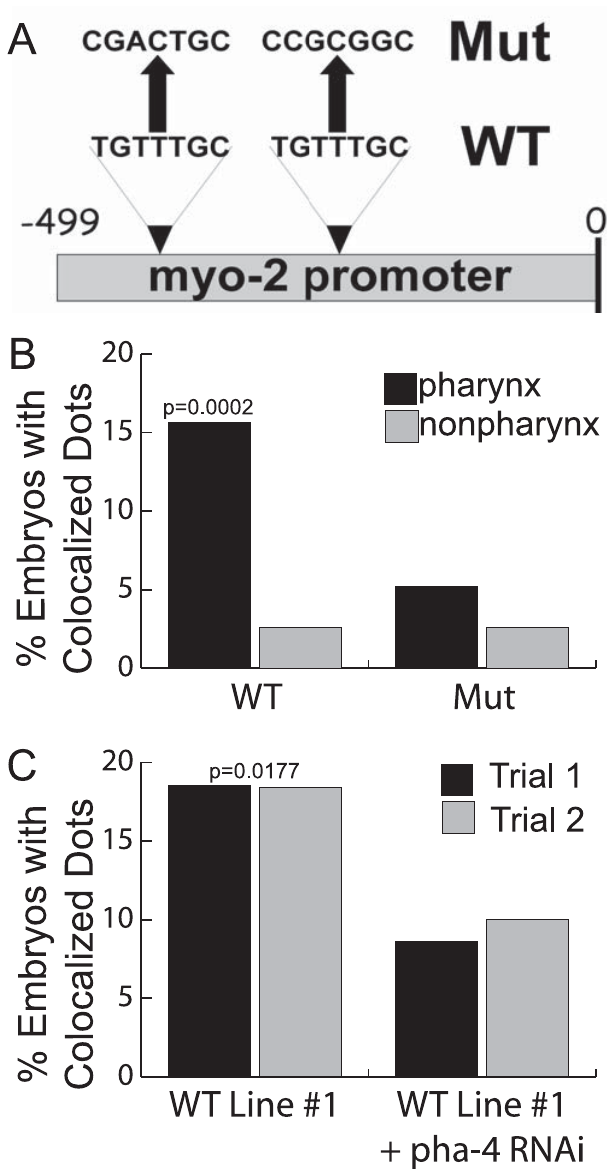
Figure 5. Association of YFP::HTZ-1 Depends on pha-4 Activity (A) Two PHA-4 binding sites within the myo-2 promoter were mutated in the myo-2 Mut construct [18]. (B) YFP::HTZ-1 association in the pharynx (black) and outside of the pharynx (grey). n ¼ 384 embryos for three wild-type (WT) lines and 192 embryos for three mutant (Mut) lines. p -value indicates a significant difference for pharyngeal association of YFP::HTZ-1 in WT versus Mut. (C) Association of YFP::HTZ-1 with the wild-type myo-2 promoter (line #1) decreased in pha-4(RNAi) embryos within pharyngeal cells. An equivalent number of images were taken at the 1.5-, 2-, and 3-fold stages of embryogenesis and . 80 embryos were imaged for each trial. p -values calculated using Fisher’s exact test. DOI: 10.1371/journal.pgen.0020161.g005